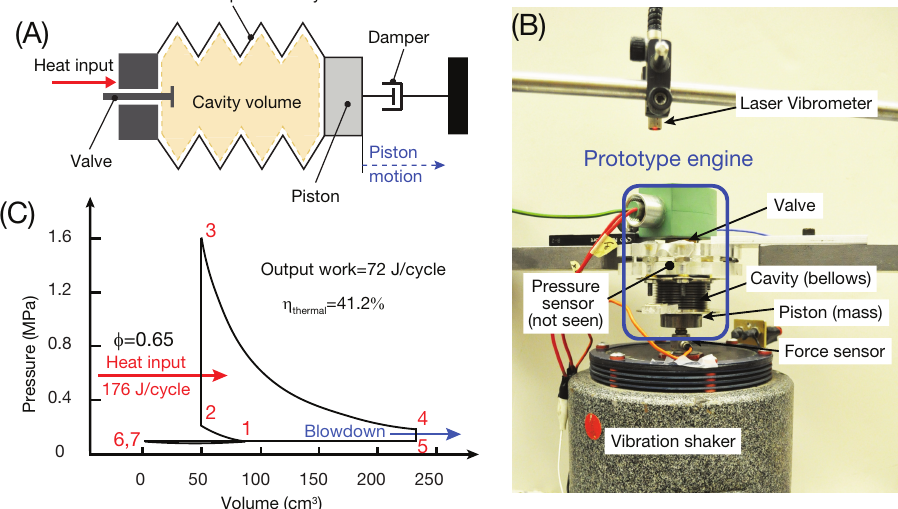
Figure 9. An overview of the miniature resonant heat engine (adapted from [6,30,37]): ( A ) a schematic sketch the engine that is modeled as a spring–mass–damper system; ( B ) a photograph of the prototype engine in the motoring test bed; and ( C ) a representative P-V diagram of the engine for an equivalence ratio φ = 0.65. Note the engine outputs 72 J/cycle at a thermal efficiency of